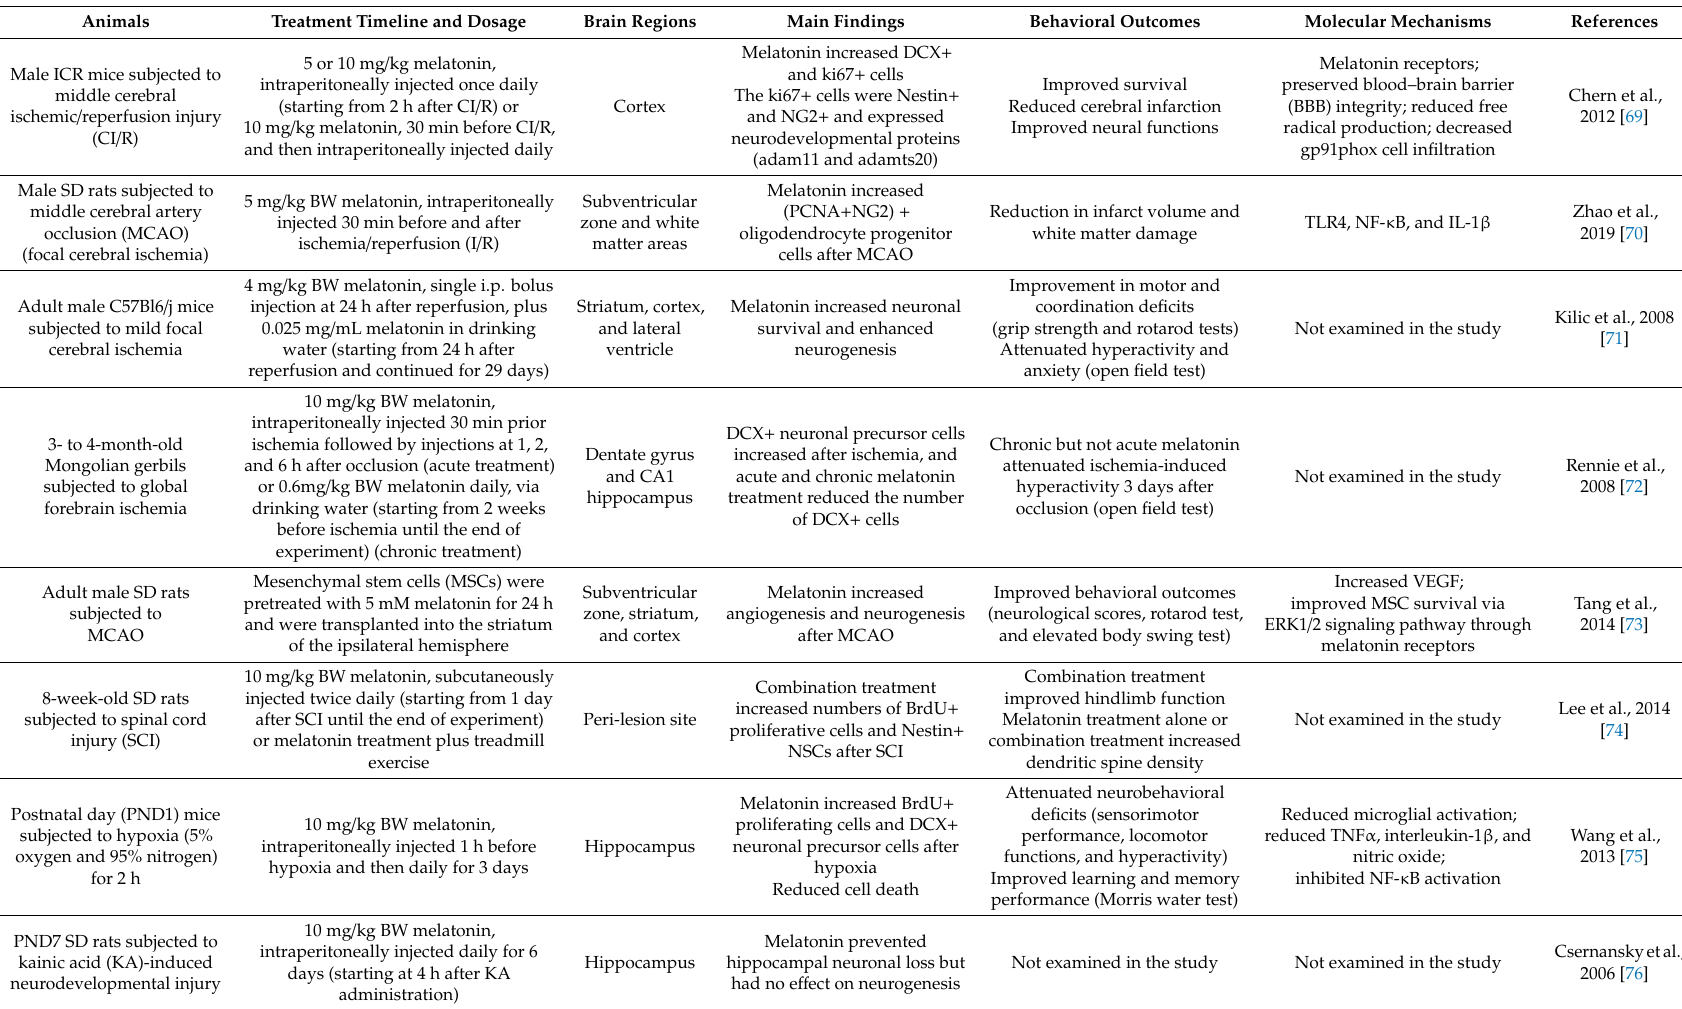
Table 6. Table showing the main findings regarding the e ff ects of melatonin on CNS injuries and the respective molecular mechanisms in the in vivo studies.